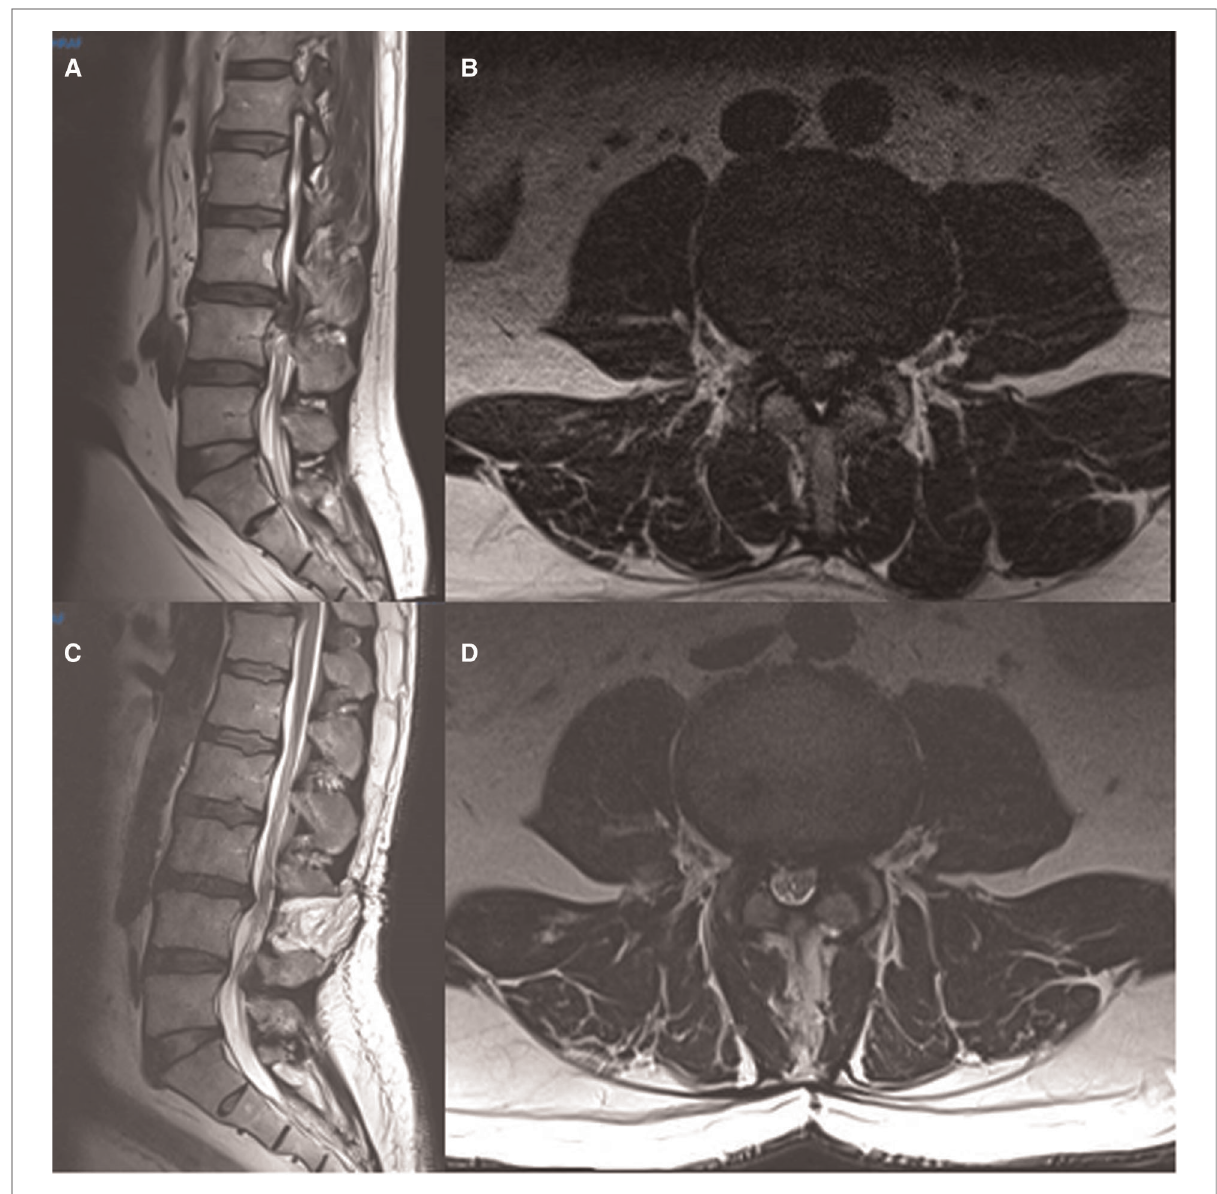
FIGURE 2 Preoperative ( A,B ) and postoperative ( C,D ) sagittal and axial MRI images of a typical patient diagnosed with an CES due to a giant L3 – 4 disc herniation and operated by open laminectomy and